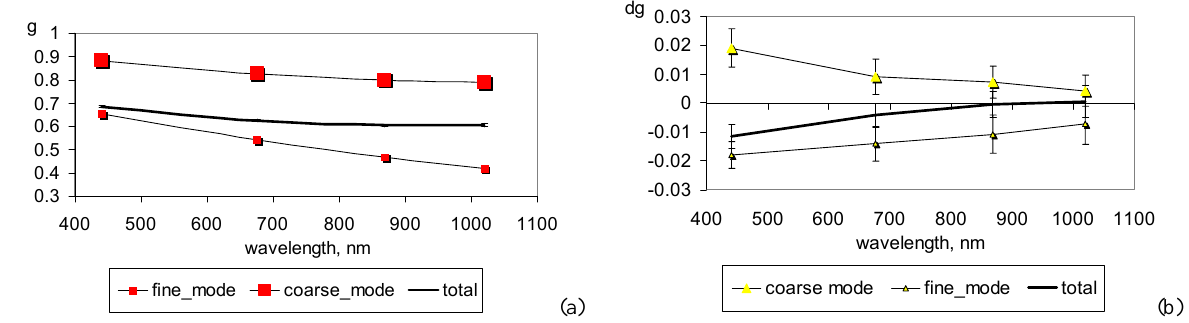
Fig. 8. Mean asymmetry factor ( g ) in Moscow for various aerosol modes (a) and the difference in mean asymmetry factor ( dg ) between